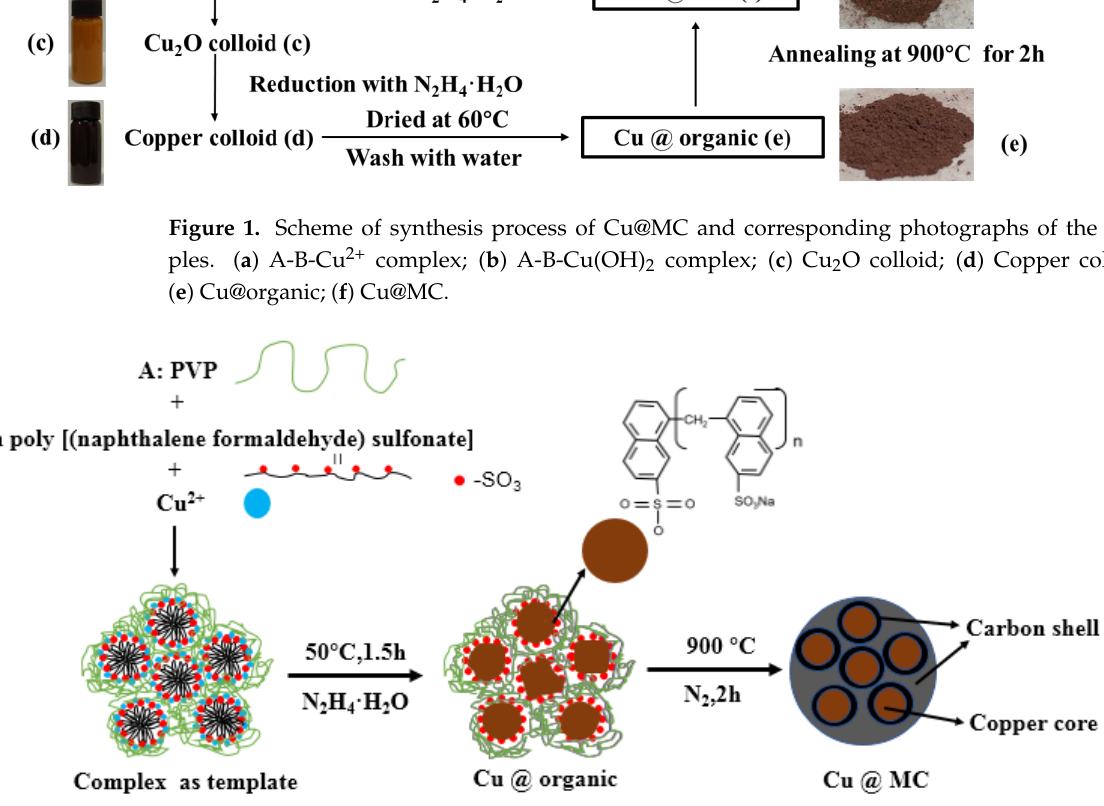
Figure 2. The proposed mechanism of forming Cu@MC.